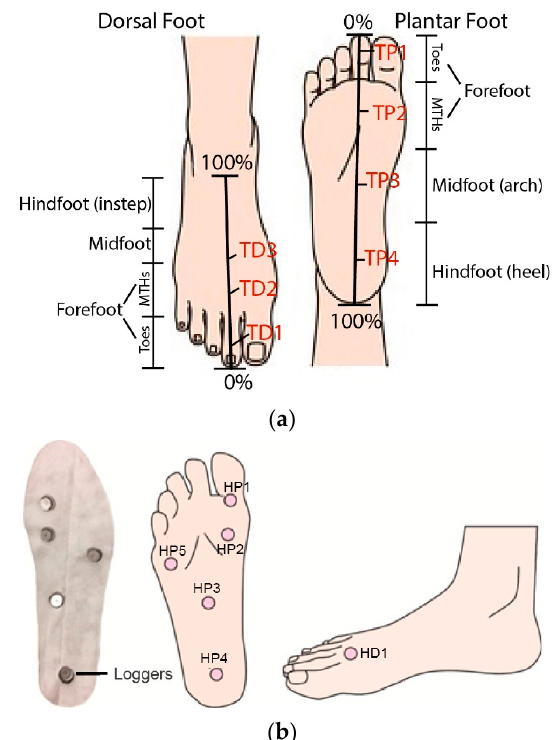
Figure 4. ( a ) Locations measured for temperature. ( b ) Locations measured for relative humidity.